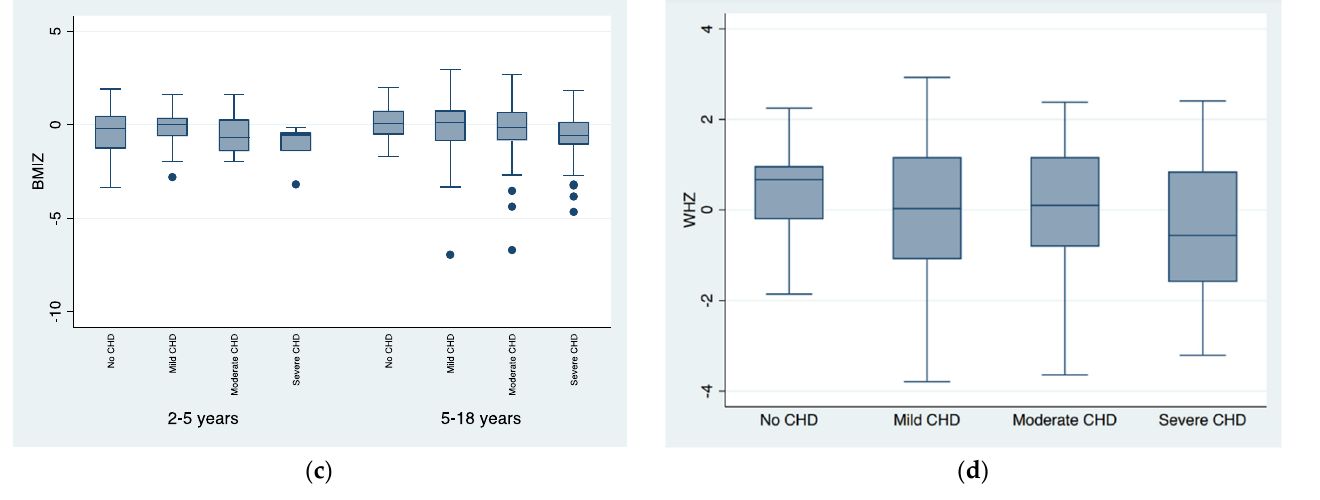
Figure 1. Box plots of length/height-for-age z-score (HZ), weight-for-age z-score (WZ), Body-Mass- Index-for-age z-score (BMIZ) and weight-for-height z-score (WHZ), stratified for the different ages and Congenital Heart Disease (CHD) severity groups . ( a ) Box plot of HZ distribution according to the different age groups and CHD severity groups; ( b ) Box plot of WZ distribution according to the different age groups and CHD severity groups; ( c ) Box plot of BMIZ distribution according to CHD severity groups in children older than 2 years of age; ( d ) Box plot of WHZ distribution according to CHD severity groups in children younger than 2 years of age.